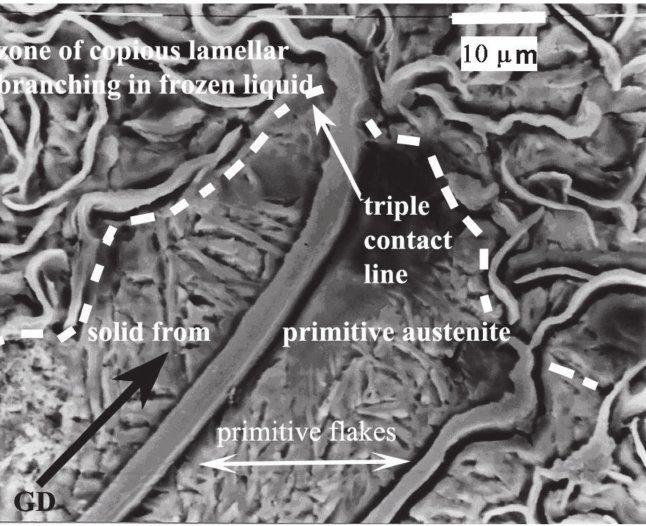
Figure 9. Frozen interface in laminar graphite Type A (LAG) shows the wavy appearance of the primary sheets once they supercool and become thinner and curlier. Special attention should be paid to the absence of pores in the section of these